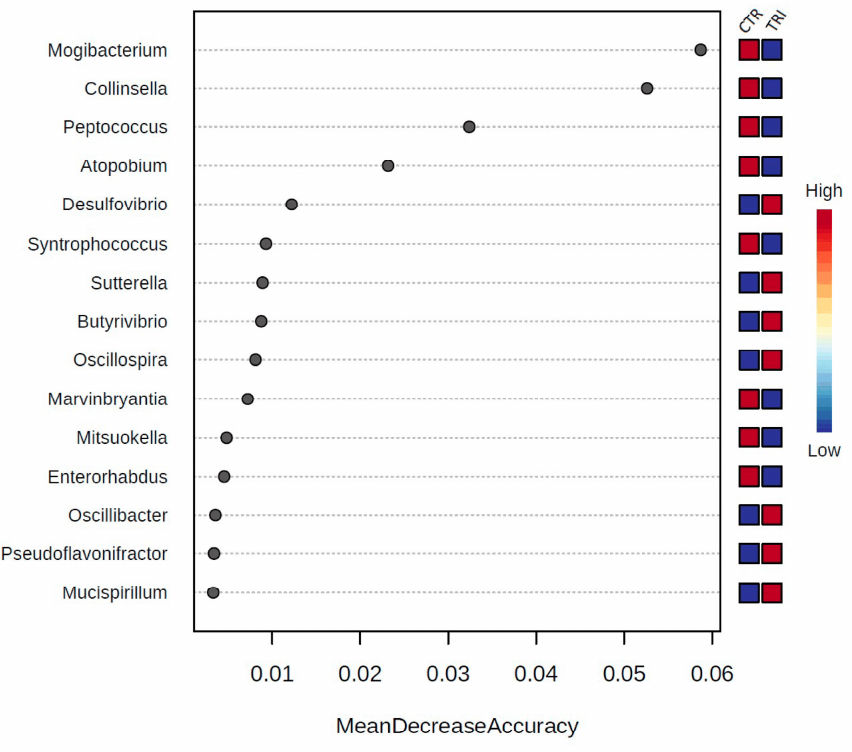
Figure 3. The 15 most discriminant genera between control and tributyrin sample sequences as determined by Random determined by Random Forest analysis using mean decrease in Forest analysis using mean decrease in accuracy.